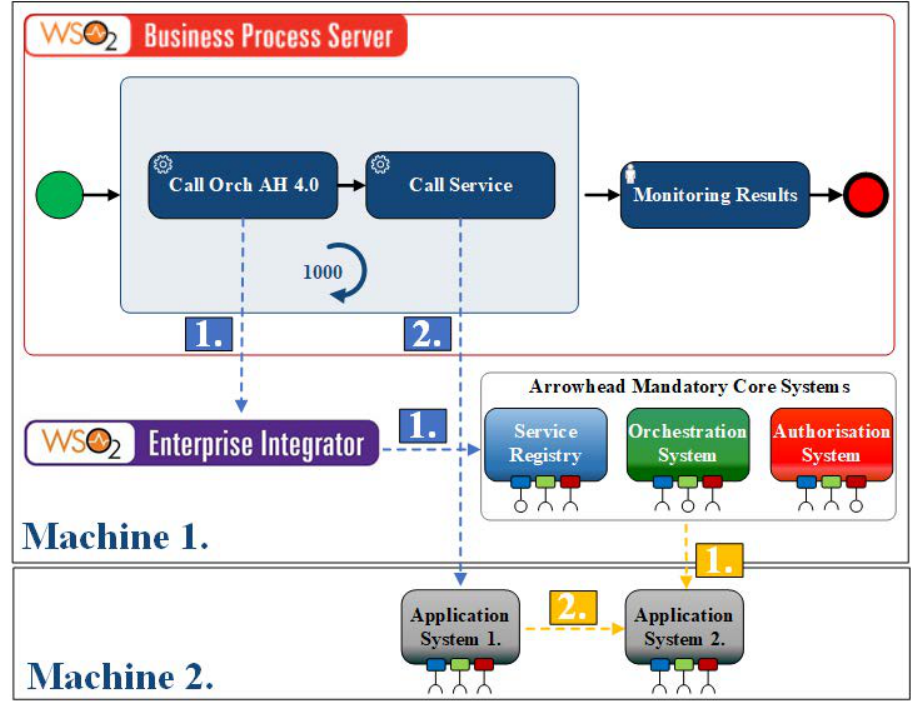
Figure 6. WSO2 Business Process Server and Enterprise Integrator managing workflow services